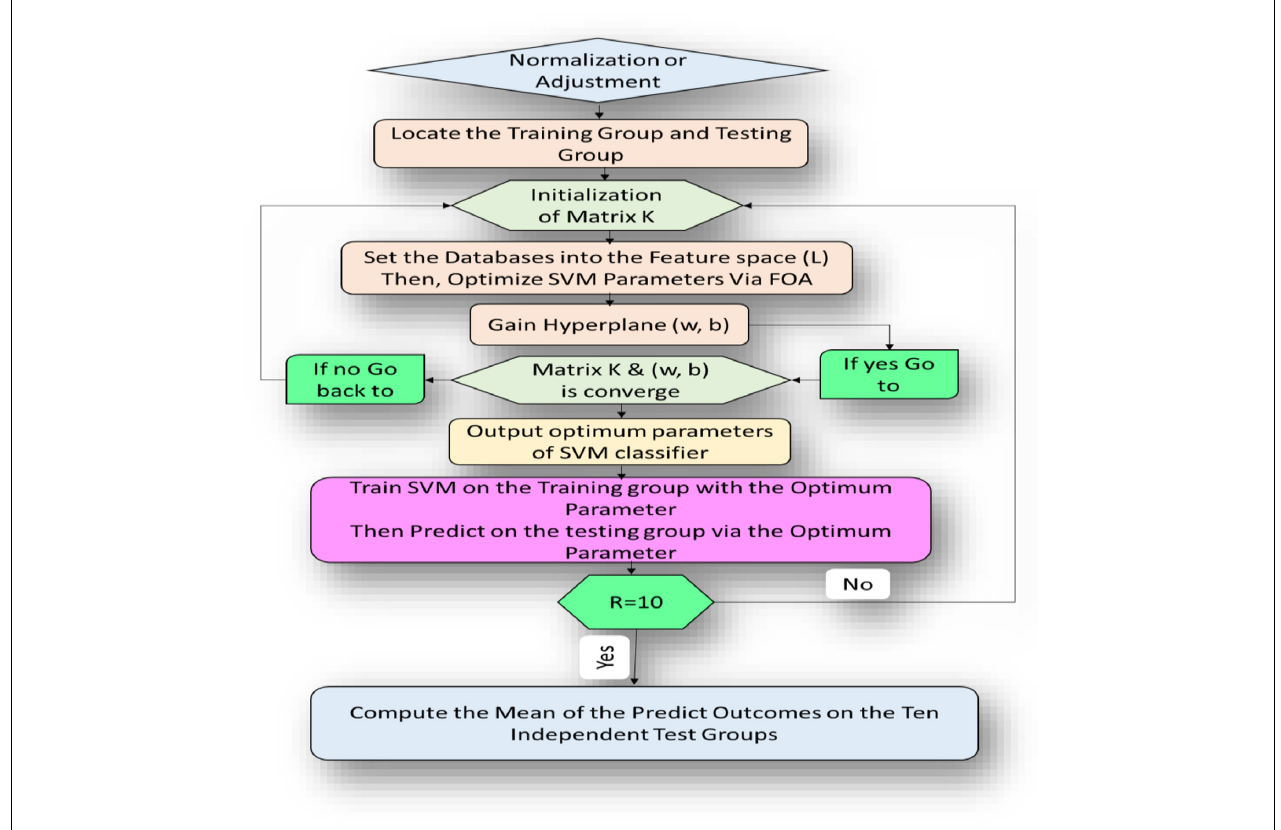
FIGURE 3 | Flow diagram representation algorithm of the proposed FOA-F-SVM